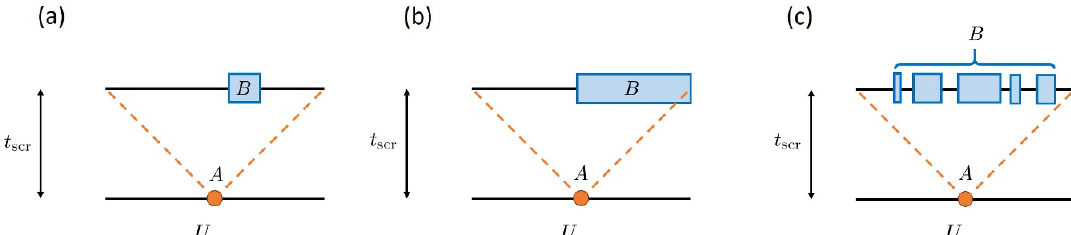
Figure 16 . A perturbation is made at some initial time, which then spreads out over a scram- bling time t scr , inside a cone (shown as dotted orange lines) bounded by the butter(cid:13)y velocity v B [36, 42, 43]. Here, time runs from bottom to top. (a) A perturbation at a barely causally in(cid:13)u- ences the subregion B , since B is less than half of the system size. (b) and (c) A perturbation at a strong causally in(cid:13)uences B , if B is greater than half of the system size. The two (cid:12)gures illustrate the cases when region B is a contiguous spatial region or the union of many contiguous